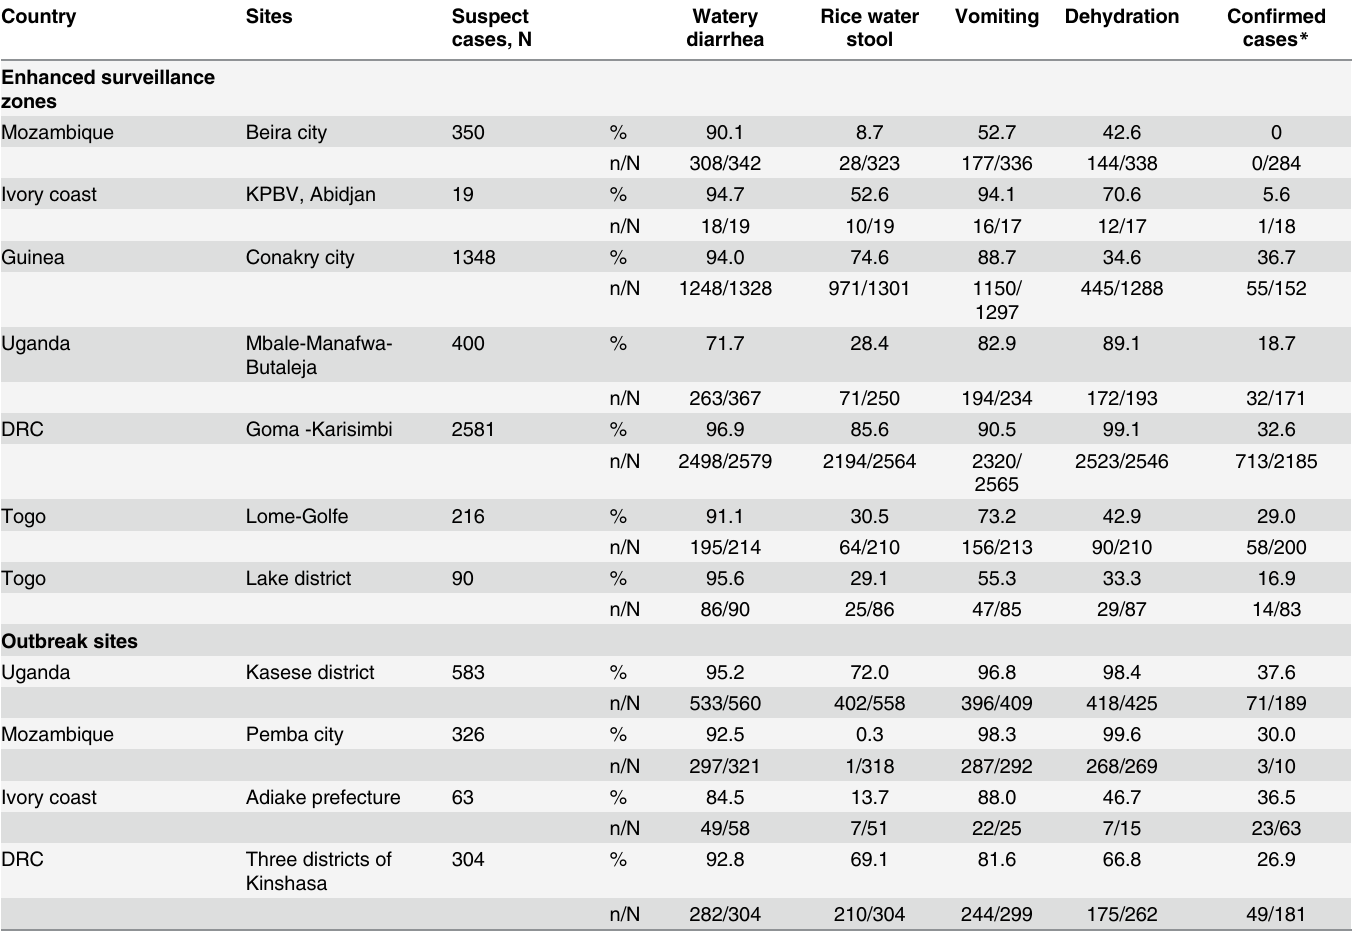
Table 4. Clinical characteristics of suspect cholera cases. N =